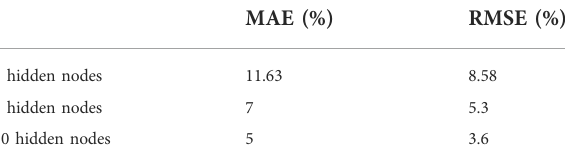
TABLE 1 Evaluation of wind power prediction for 1 day.